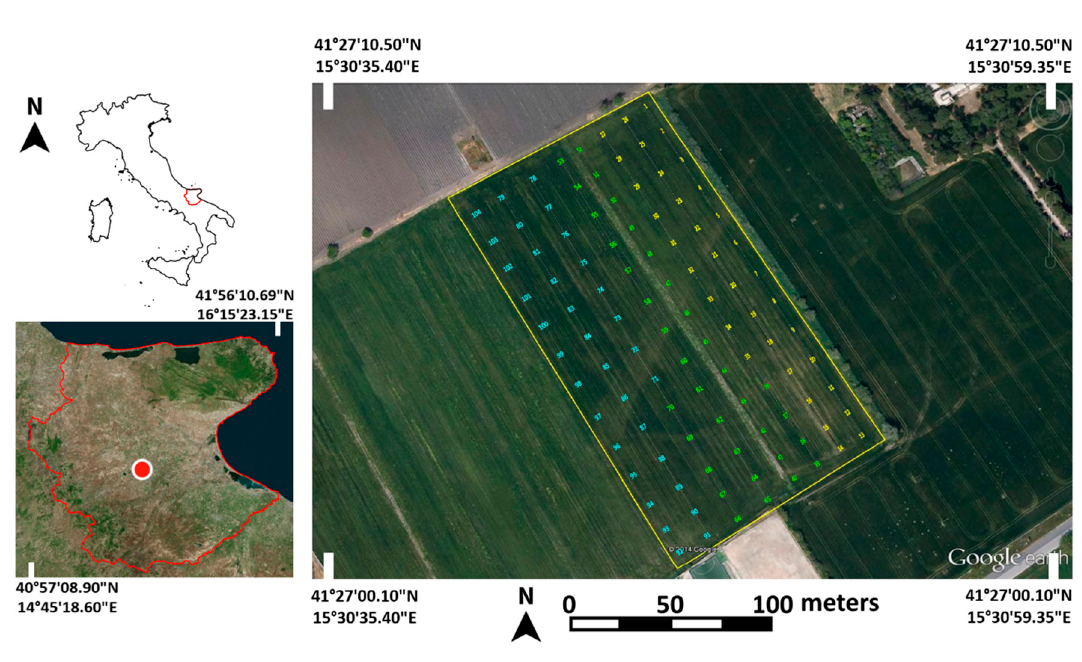
Figure 1. Location of study site and 104 sampling points.